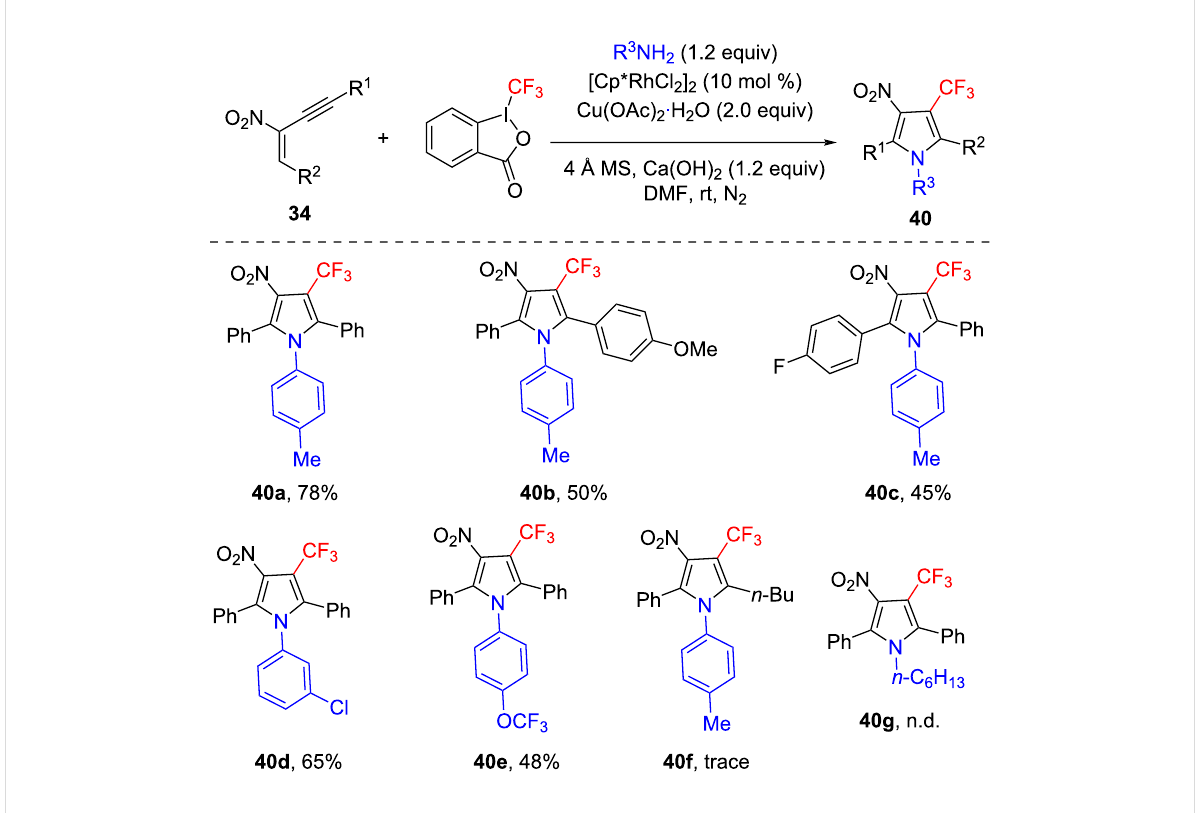
Scheme 15: Tandem cyclization of 2-nitro-1,3-enynes, Togni reagent II, and